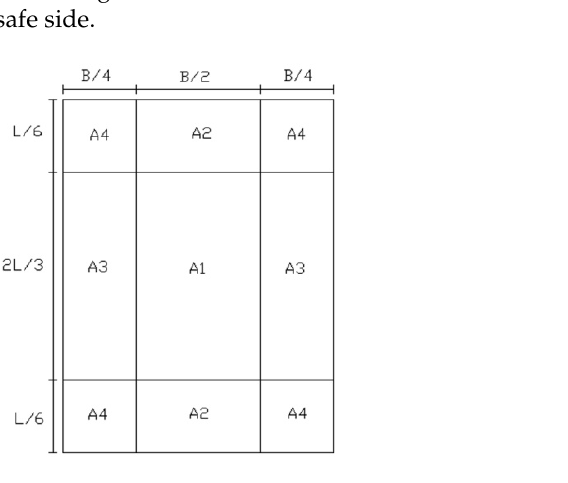
Figure 7. Different zones of sub grade reaction modulus values to calculate the b coefficient. Table 3. Values of the b coefficient in Equation (2) based on different zones in Figure 7. Position Based on the Figure